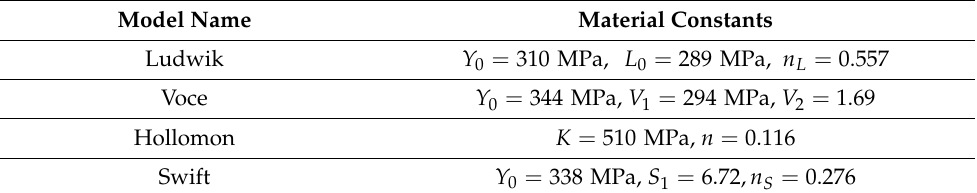
Figure 15. Comparison of deformed shapes of the tensile test, predicted using the RFS and funda- mental flow models: ( a ) RFS; ( b ) Fundamental flow models. Table 2. Material constants of the four fundamental flow models focused on pre-necking. Table 3. Material constants of the four fundamental flow models focused on post-necking.